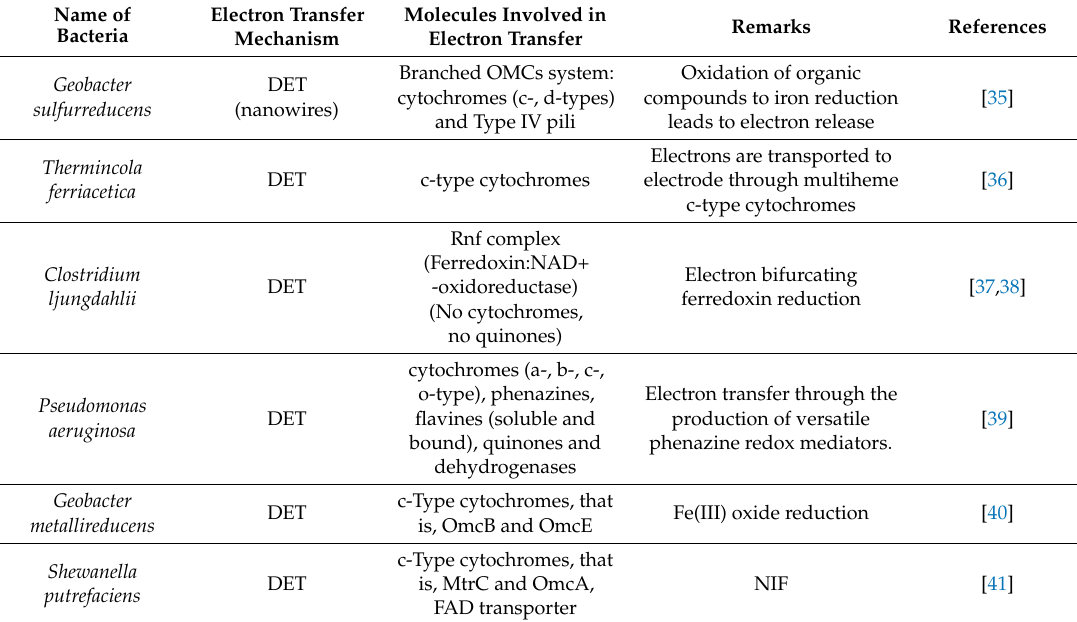
Table 1. Electroactive bacteria and molecules involved in extracellular electron transfer (EET) within the electrode-microbe interfaces in bioelectrochemical systems